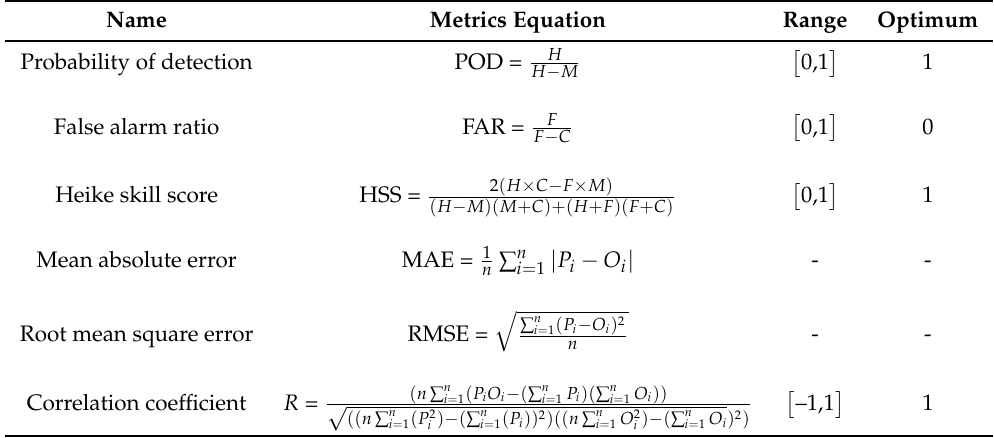
Table 2. Validation metrics with equation, theoretical range, and optimum